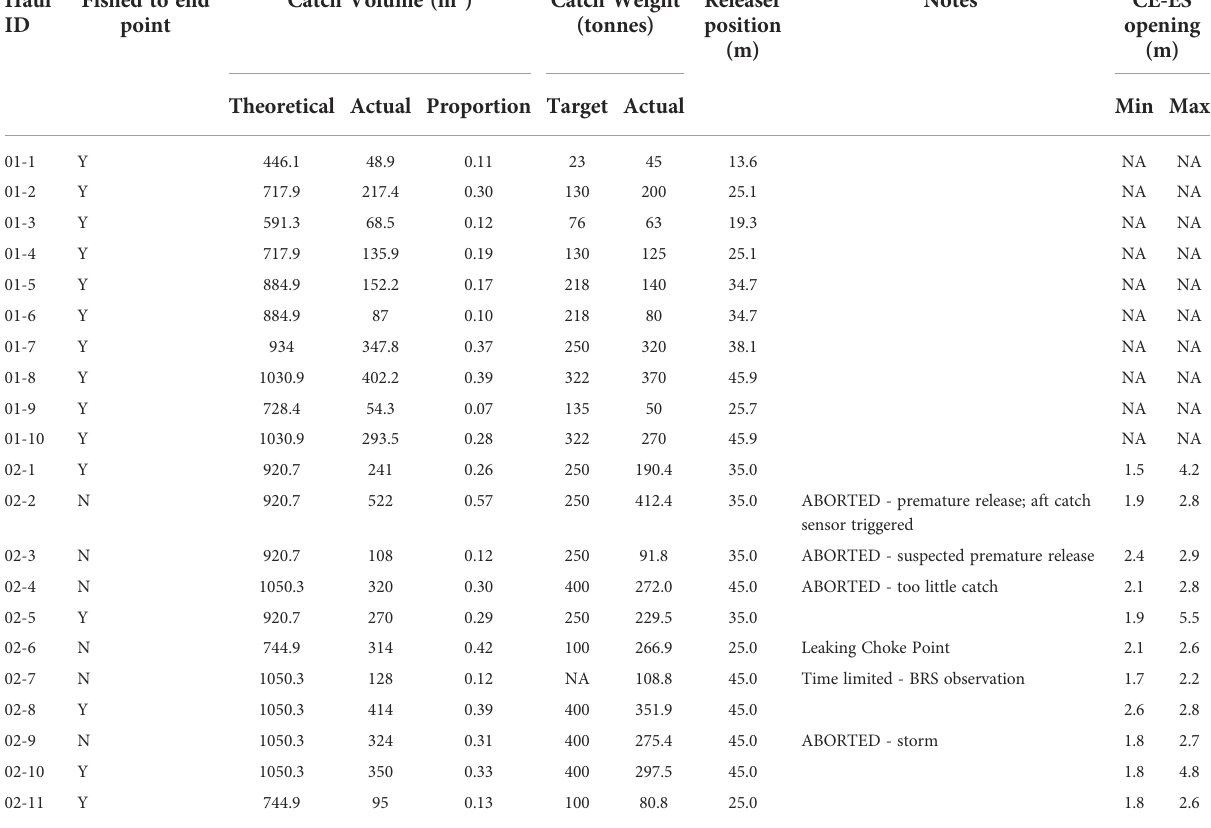
TABLE 3 Overview of the Catch Volume and weight for each haul, with respect to the position of the catch limitation releaser. Haul